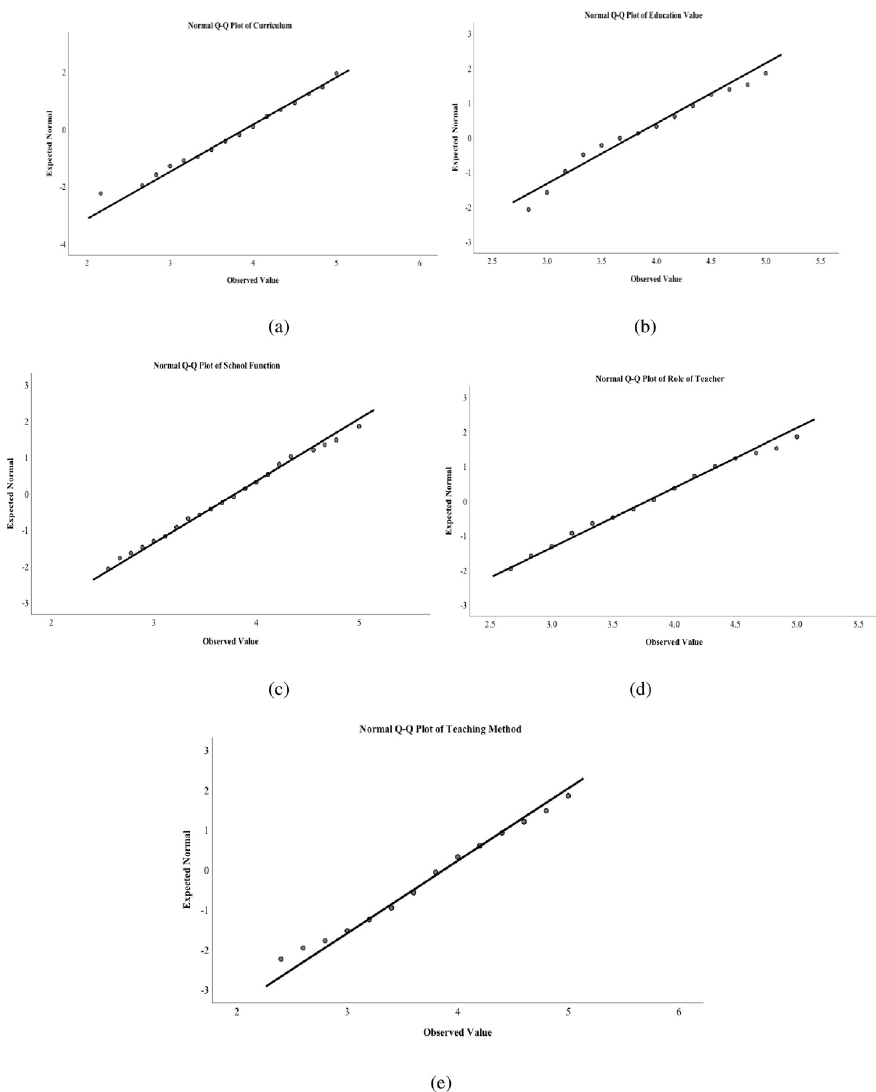
Fig 1. Q-Q plots for the distribution of teacher perception on curriculum (a), education values (b), school function (c), teacher roles (d), and methods of teaching (e).